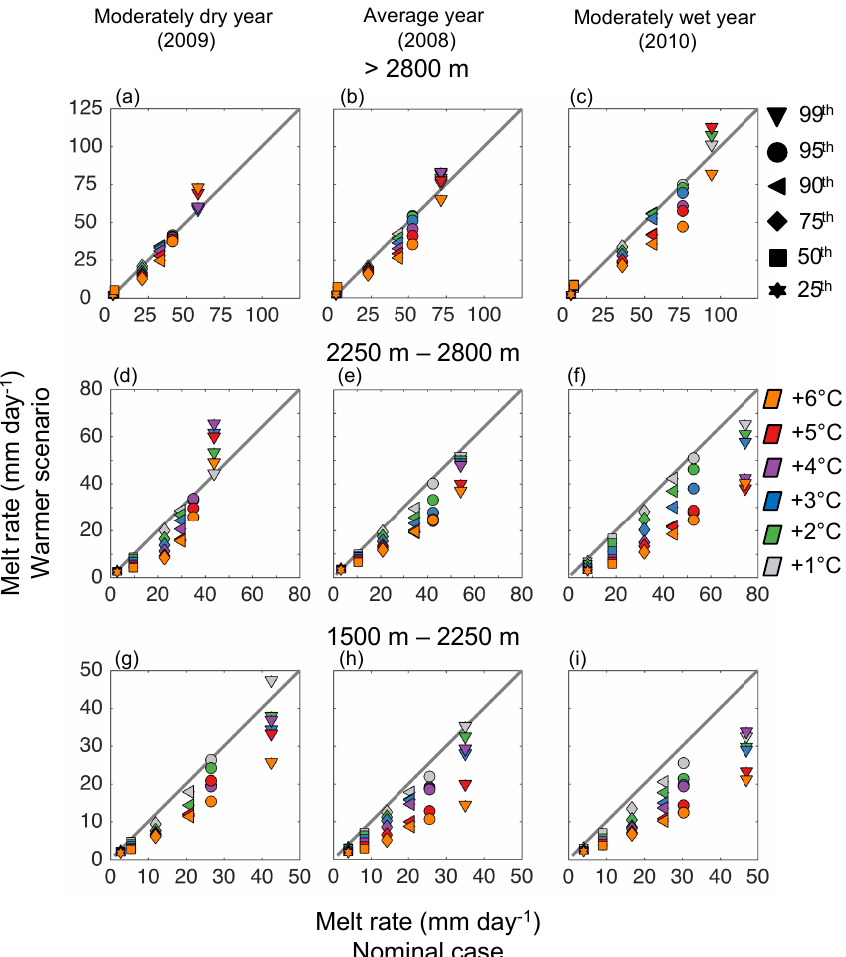
Figure 9. Quantile plots of simulated melt rates for the nominal ( x axes) and warmer scenarios ( y axes) for model grid cells characterized as high elevation (>2800m; a, b, c ), middle elevation (2250–2800m; d, e, f ), and lower elevation (1500–2250m) regions for the moderately dry year (a, d, g) , average year (b, e, h) , and moderately wet year (c, f, i) . Marker colors correspond to the six different temperature perturbations. Plotted in each graph are the 25th, 50th, 75th, 90th, 95th, and 99th percentiles (marker shapes) of daily snowmelt rates ≥ 1mmday − 1 for all grid cells within each water year and elevation range. The 1 : 1 lines are plotted for